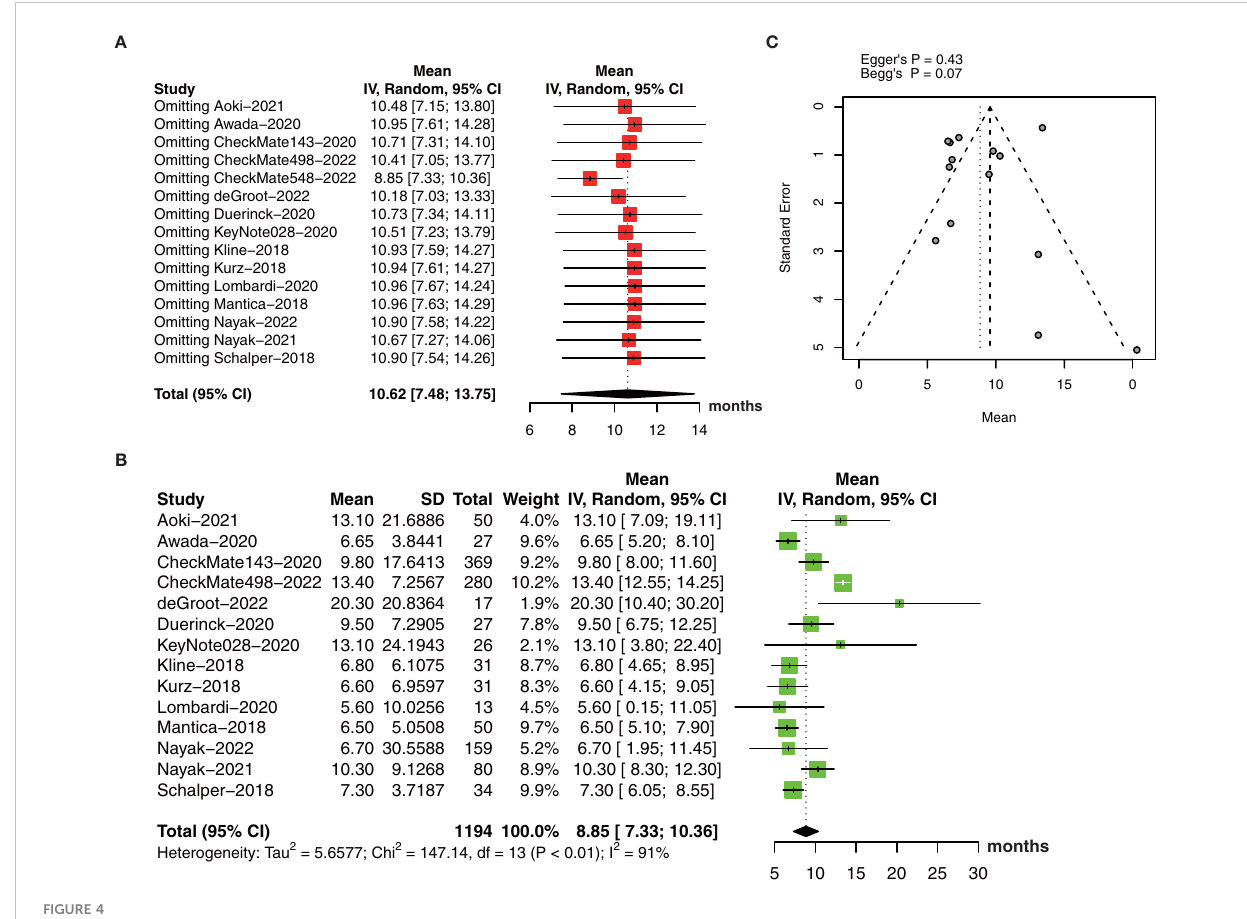
FIGURE 4 (A) The pooled estimate of median OS. (B) sensitive analysis. (C) the adjusted pooled estimate of median OS. OS, overall survival.